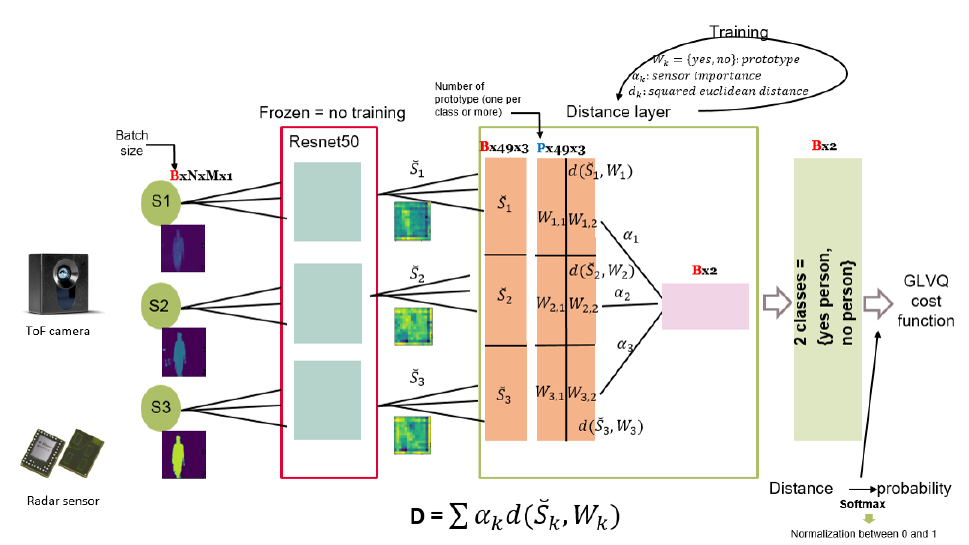
Figure 4. ToF/Radar fusion system for image (human) classification and sensors’ contribution evaluation.